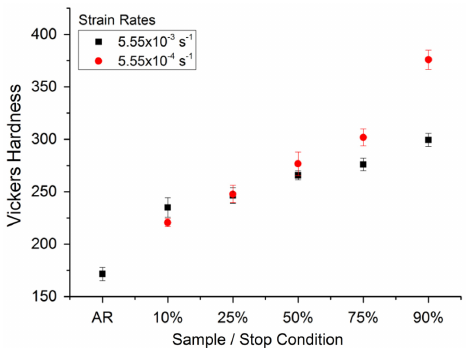
Figure 5. Vickers hardness as a function of stop condition, for samples deformed at two different strain